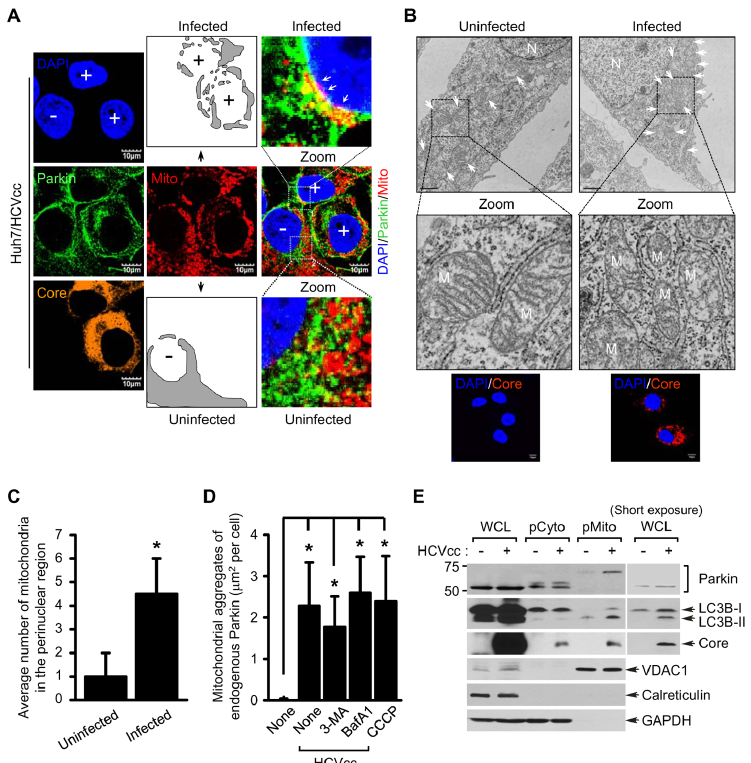
Figure 1. HCV infection induces perinuclear clustering of mitochondria and Parkin translocation to mitochondria. ( A ) Representative confocal images showing perinuclear clustering of mitochondria and Parkin aggregates on the mitochondria in Huh7 cells infected with HCVcc. At 3 days post-infection, cells prestained with MitoTracker (Mito, red) were immunostained with anti-Parkin (green) and HCV core (orange) antibodies. Nuclei were stained with DAPI (blue). Infected ( + ) and uninfected cells ( 2 ) are marked. The illustrated images display typical distribution of mitochondria in uninfected cells and altered distribution of mitochondria in the perinuclear region of infected cells (gray). In the zoomed images, the white arrows indicate accumulation of endogenous Parkin recruited to the mitochondria in HCV-infected cells (yellow). ( B ) Ultrastructure of HCV- infected cells showing perinuclear clustering of damaged mitochondria. Control naı¨ve Huh7 cells (left) and stable cells harboring HCV full-length replicon FLR-JFH1 (right) were examined by electron microscopy. In the zoomed images, typical ultrastructure of mitochondria in naı¨ve cells and ultrastructural abnormalities of mitochondria in HCV replicon cells are shown. Organelle mark: N, nucleus; M and white arrow, mitochondria. Scale bar=1 m M. Fluorescent images (below) indicate the expression of HCV core protein in HCV replicon cells. Cells were immunostained with anti-HCV core antibody (red). Nuclei were stained with DAPI (blue). ( C ) Quantification of the number of mitochondria in the perinuclear region (mean 6 SEM; n $ 5 cells; * p , 0.05). ( D ) Quantification of fluorescence intensity of Parkin aggregates on the mitochondria in CCCP-treated (see Figure S1 ) or HCV- infected cells ( A ) and those treated with 3-MA or BafA1, respectively (see Figure 4A ) (mean 6 SEM; n=10 cells; *p , 0.01 ). P values were calculated by using an unpaired Student’s t-test. ( E ) Western blot analysis showing endogenous Parkin recruitment to mitochondria in HCV-infected cells. Huh7 cells were infected with HCVcc. At 5 days post-infection, pure cytoplasm and mitochondria fractions were isolated by ultracentrifugation as described in Materials and Methods. Cellular fractions of HCV-infected cells were analyzed by immunoblotting using antibodies specific for the indicated proteins. Fractions: whole cell lysates, WCL; purified cytoplasm, pCyto; purified mitochondria, pMito. Organelle markers: VDAC1, mitochondria; Calreticulin, ER; GAPDH,